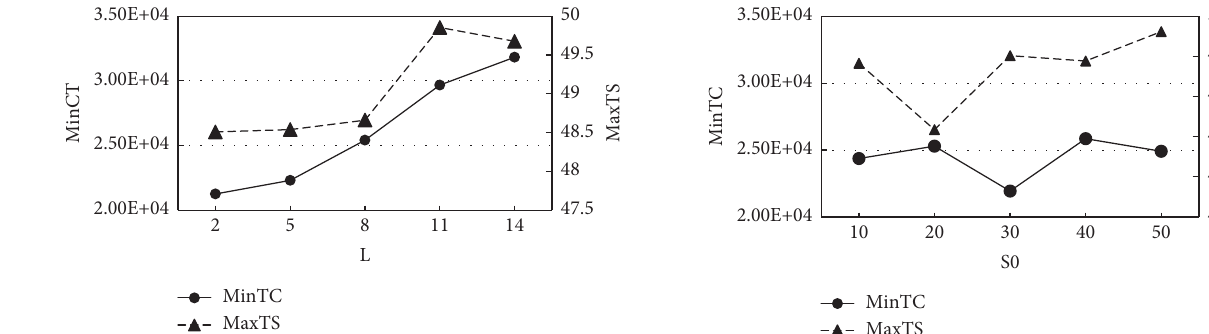
5: Sensitivity analysis of shortage